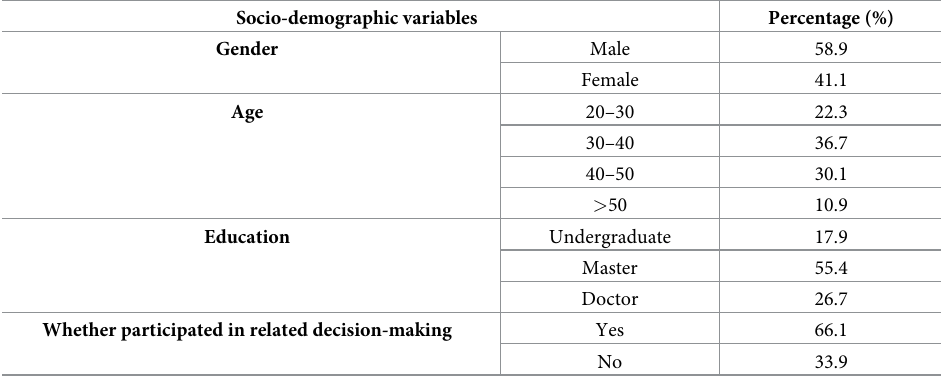
Table 7. Frequency distribution of socio-demographic characteristics.